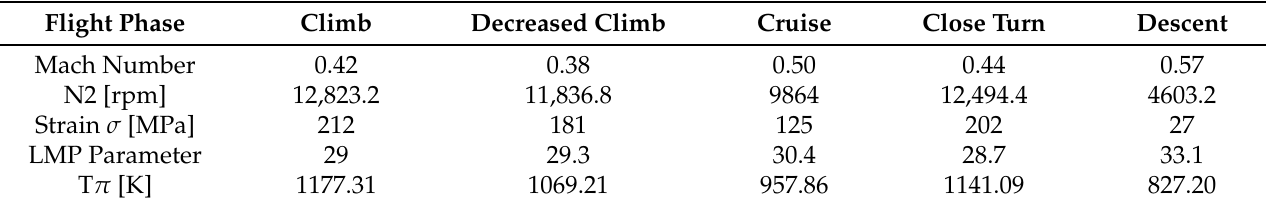
Table 7. EMB-145 mission creep main